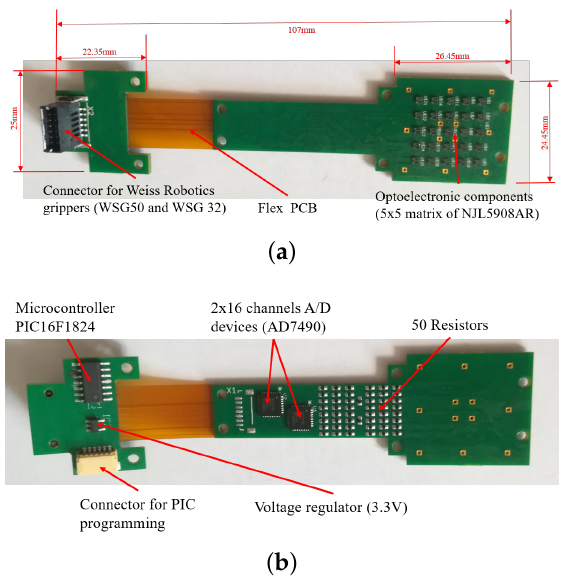
Figure 2. The tactile sensor PCB: a top view with dimensions ( a ) and a bottom view ( b ) with the components